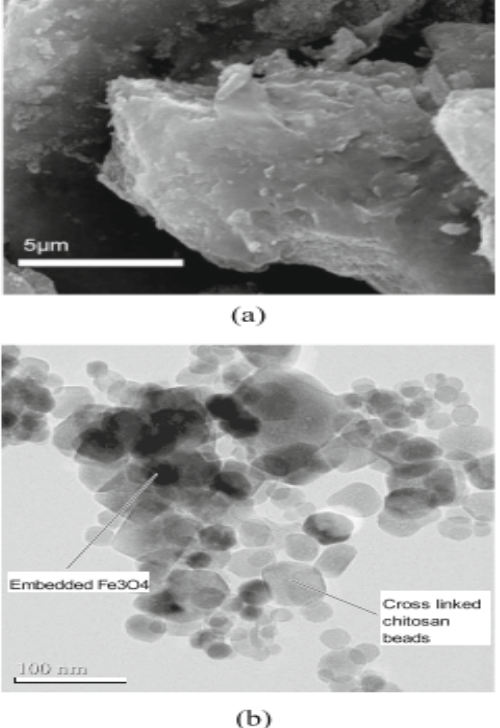
Figure 6. SEM ( a ) and TEM ( b ) micrographs of the magnetic chitosan Sorption adapted with permis- sion from [58].